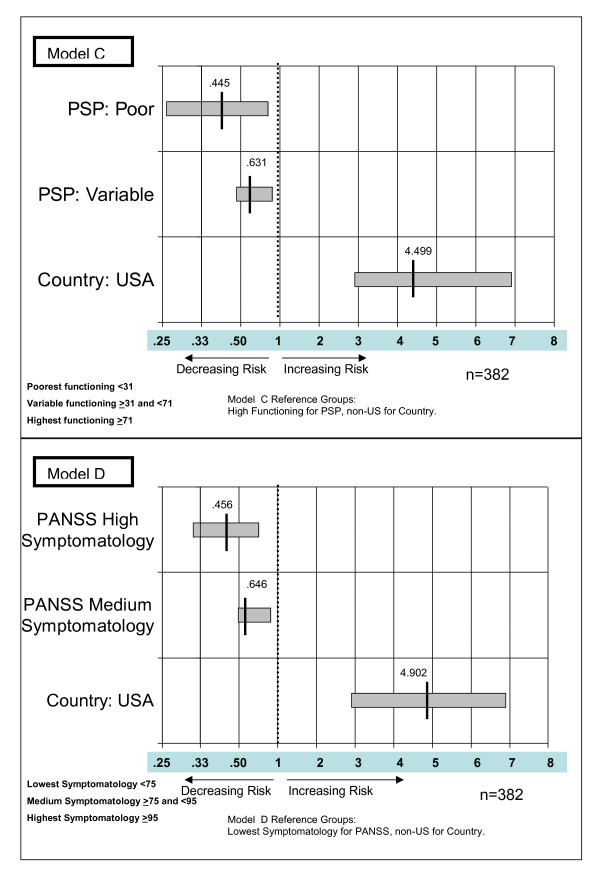
Hazard ratios for significant variables in the two Cox proportional hazard regression models predicting hazard (chance) of hospital discharge using Personal and Social Performance (PSP) scale (model C) and Positive And Negative Syndrome Scale (PANSS) (model D).